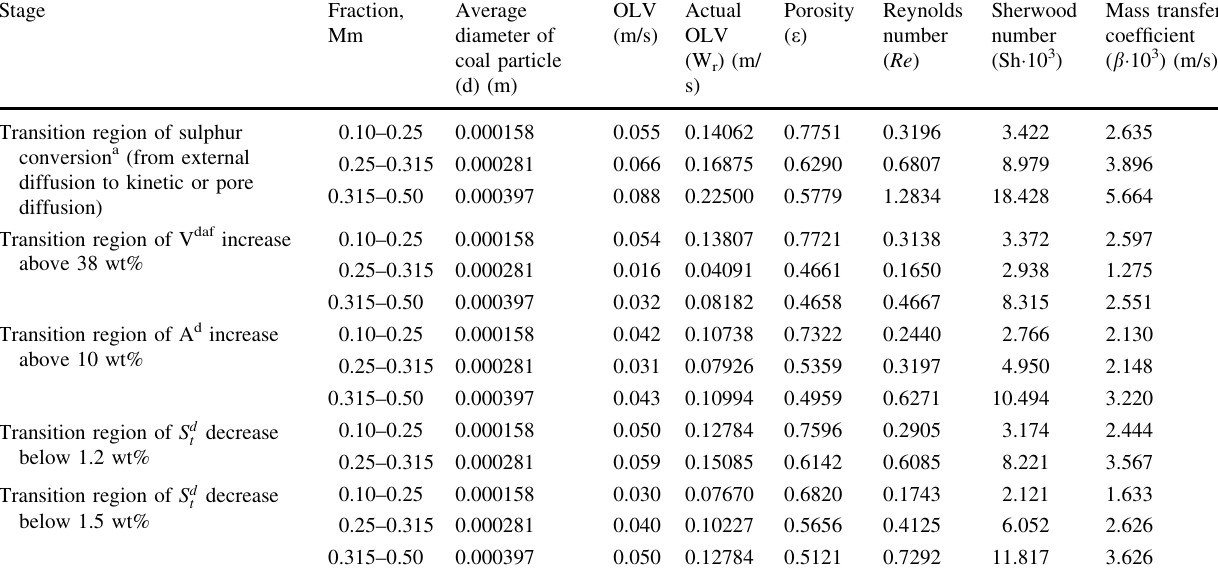
Table 11 Dependence of the pyritic sulphur conversion stages on fluidized bed parameters and mass transfer criteria